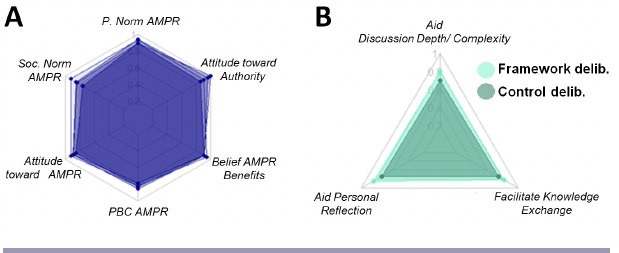
Fig. 5 . (A) Radar plot of baseline mean psychometric constructs for each of the four survey regions; scaled between 1 (more positive toward the responsible fishing area [AMPR] and regulatory authority) and 0 (See Appendix 1). (B) Radar plot of postdiscussion assessments by the participants of the activity; scaled between 1 (strong agreement) and 0 (strong disagreement; See Appendix 2). PBC AMPR = Perceived behavioral control toward the AMPR; P. Norm AMPR = Personal norm toward the